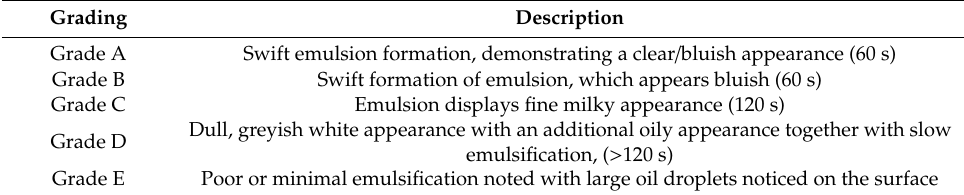
Table 1. Grading system for emulsification behavior exhibited by SEDDSs upon